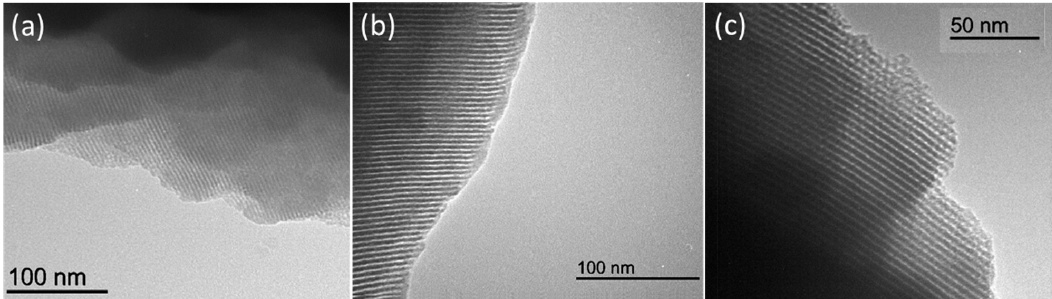
Figure 2. TEM images of Cl-EtPMO ( a ), Im-EtPMO ( b ), and Im-EtPMO-Co ( c ). Im-EtPMO and Im-EtPMO-Co materials exhibited type-IV isotherms according to the IUPAC [34] with a condensation step at P/P 0 = 0.3–0.7, characteristic of mesoporous materials (Figure 3). Both materials showed a non-distinctive hysteresis loop, which is typical of materials with small mesopores [35]. The narrow pore size distribution and average pore size confirmed pores in the meso range. Table 1 summarizes the textural properties of the materials. Im-EtPMO showed a BET surface area, pore volume, and pore diameter of 583 m 2 g − 1 , 0.5 cm 3 g − 1 , and 4.2 nm, respectively. The anchoring of the molecular cobaloxime catalyst on the pendant imidazole groups gave rise to a slight decrease in surface area and pore